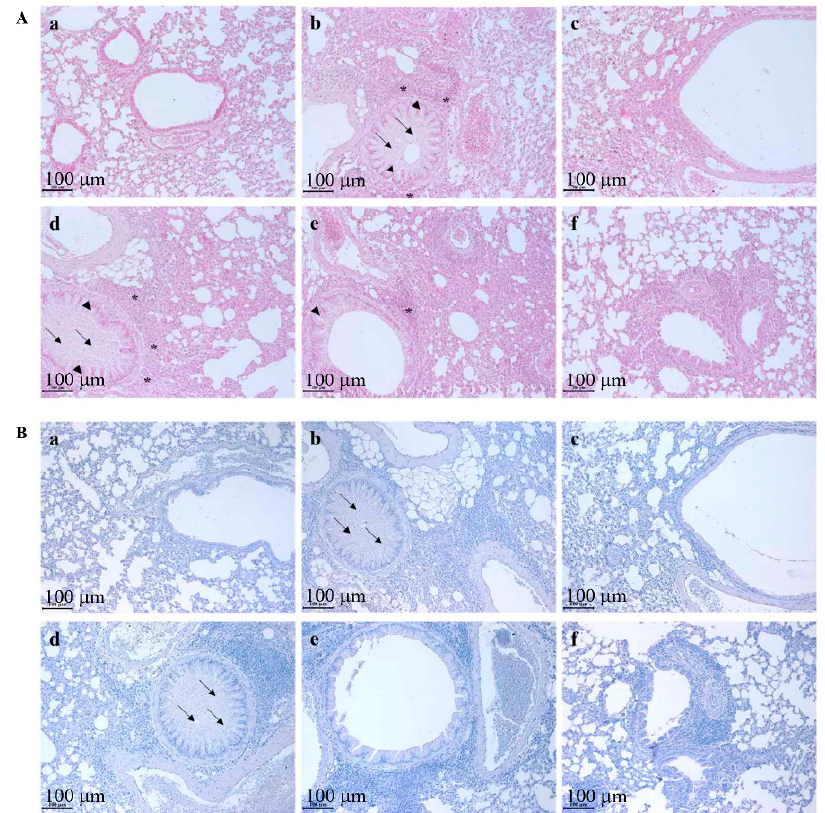
Figure 2. C. laceolata prevented the ovalbumin-induced asthmatic representative morphological changes in the pulmonary system, such as airway remodeling, mucous hypersecretion, epithelial cell hyperplasia and inflammatory cell infiltration. ( A ) The photos of the hematoxylin and eosin (H&E) stained results. a, The normal lung. b, Ovalbumin treatment increased mucous secretion in the bronchioalveolar ducts (arrow), overgrowth of the pulmonary epithelial cells (arrow head), and infiltration of the inflammatory cells near the bronchioalveolar ducts and vessels (asterisk mark). c, Dexamethasone treatment decreased the ovalbumin-induced morphological changes. d, The changes in the lung in the 50 mg/kg/day C. laceolata treatment group were similar to those in the ovalbumin treatment group. e, In the 150 mg/kg/day C. laceolata treatment group, the severity of the ovalbumin-induced pulmonary changes was lower than in both the ovalbumin treatment group and in the 50 mg/kg/day C. laceolata treatment group, although it was higher than in both the dexamethasone treatment group and in the 300 mg/kg/day C. laceolata treatment group. f, The 300 mg/kg/day C. laceolata treatment effectively inhibited the ovalbumin-induced epithelial cell hyperplasia and inflammatory cell infiltration. ( B ) The results of the periodic acid schiff (PAS) stain. a, The normal lung. b, Ovalbumin-stimulated mucous hypersecretion (arrows). c, Dexamethasone effectively controlled the mucous secretion. d, The mucous secretion level in the 50 mg/kg/day C. laceolata treatment was similar to that in the ovalbumin treatment group. e, In the 150 mg/kg/day C. laceolata treatment group, the mucous secretion was significantly decreased. f, The level of mucous secretion in the 300 mg/kg/day C. laceolata treatment group was similar to that in the dexamethasone treatment group. Scale bar, 100 µ m; magnification, ×